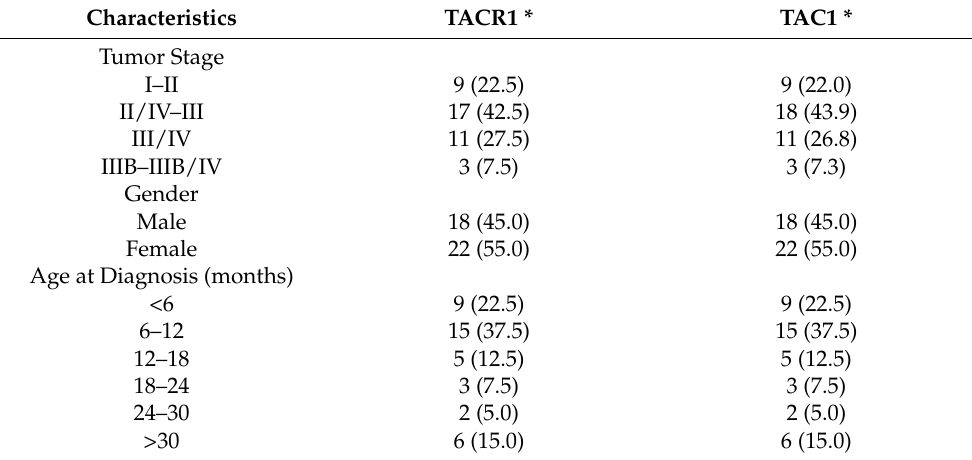
Table 3. Summary of clinical outcome and biological characteristics of the patients from database